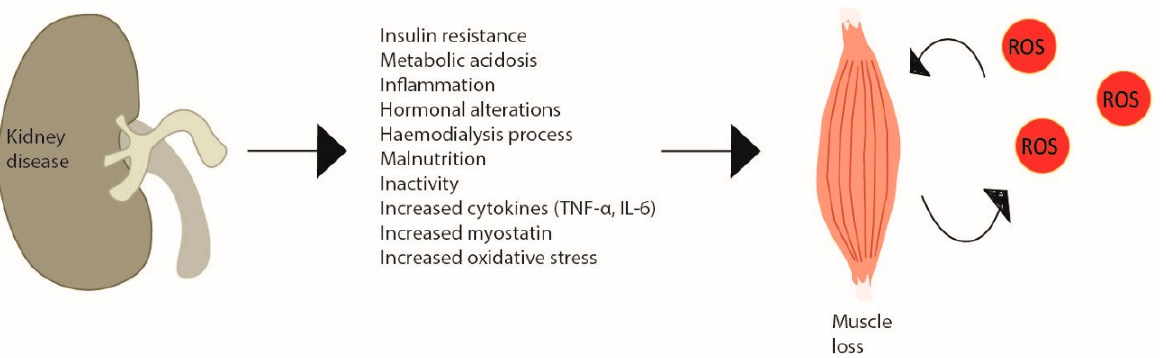
Figure 3. Skeletal muscle wasting induced by chronic kidney disease. Chronic kidney disease creates metabolic changes due to inflammation, haemodialysis increased cytokine production and myostatin and especially oxidative stress, which leads to skeletal muscle atrophy inducing a catabolic program and a vicious cycle of ROS production in site. In CKD patients, this is observed by decreased muscle strength and increased weakness.